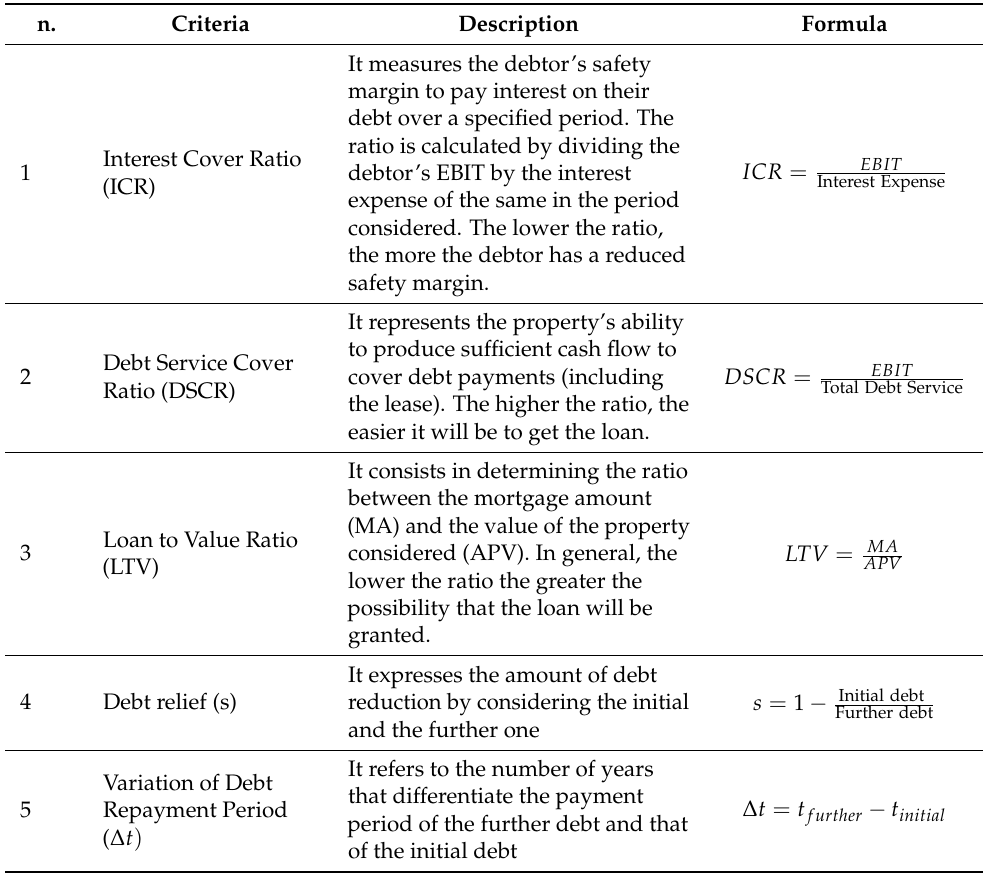
Table 3. Description of the criteria